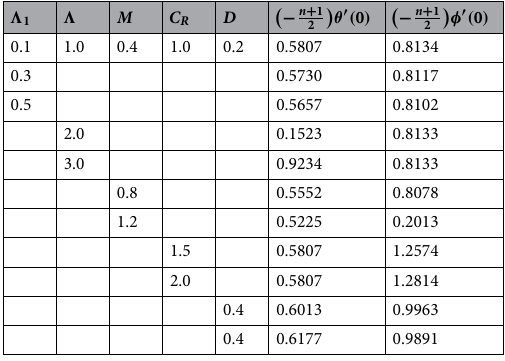
Table 2. The statistical outputs of Sherwood and Nusselt numbers.